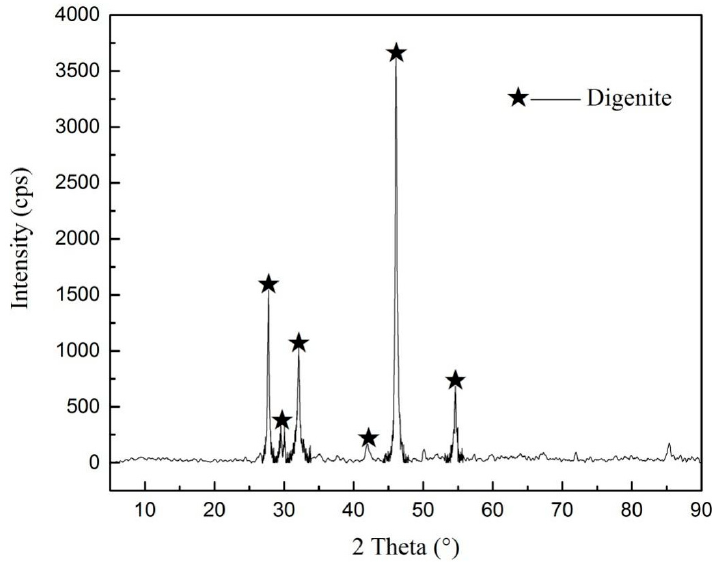
Figure 1. X ‐ ray diffraction pattern of digenite. Figure 1. X-ray diffraction pattern of